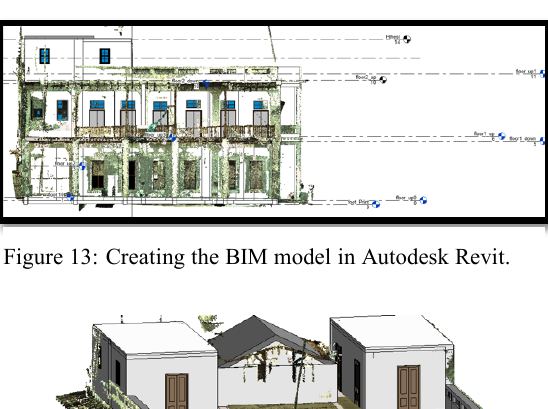
Figure 11: Inserting the 3D point cloud into Autodesk Revit.